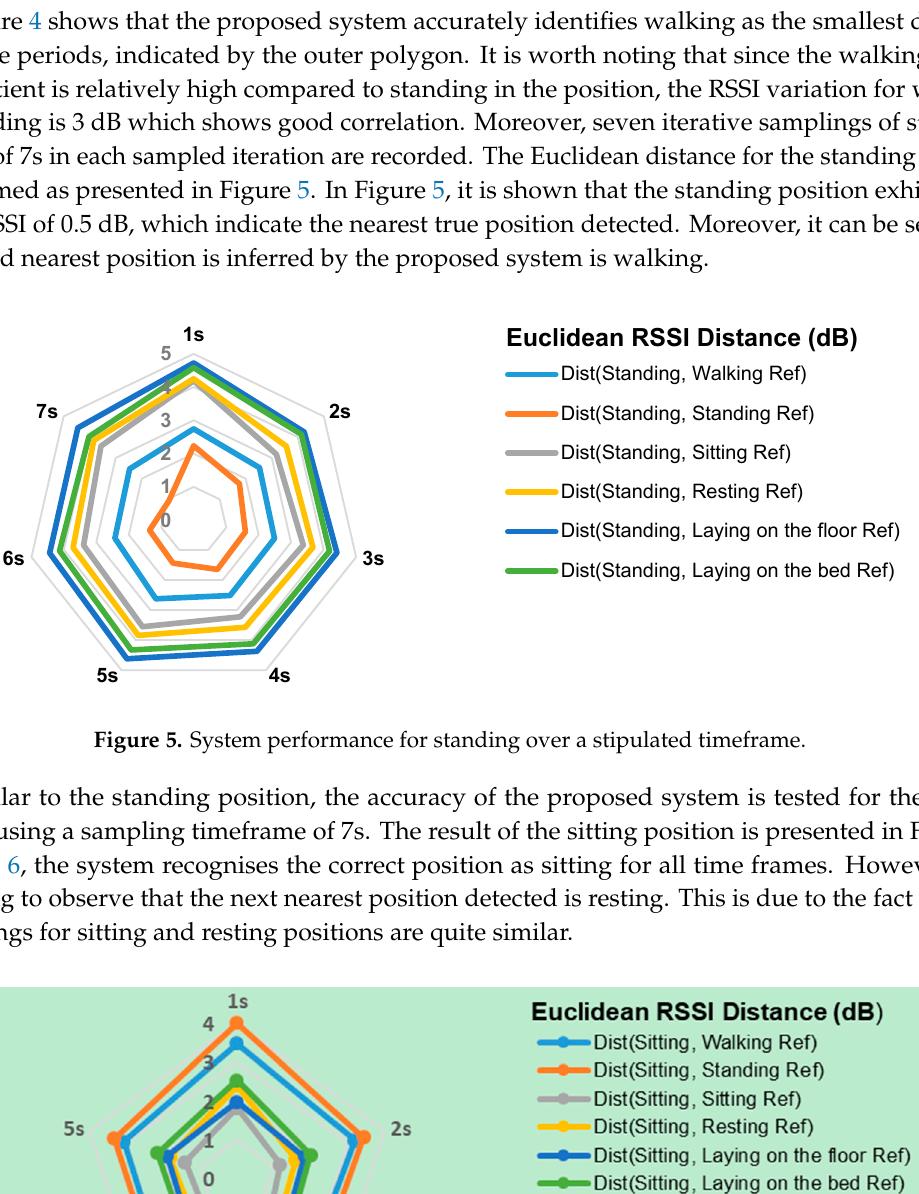
Figure 4. System performance for walking position within the measured time.